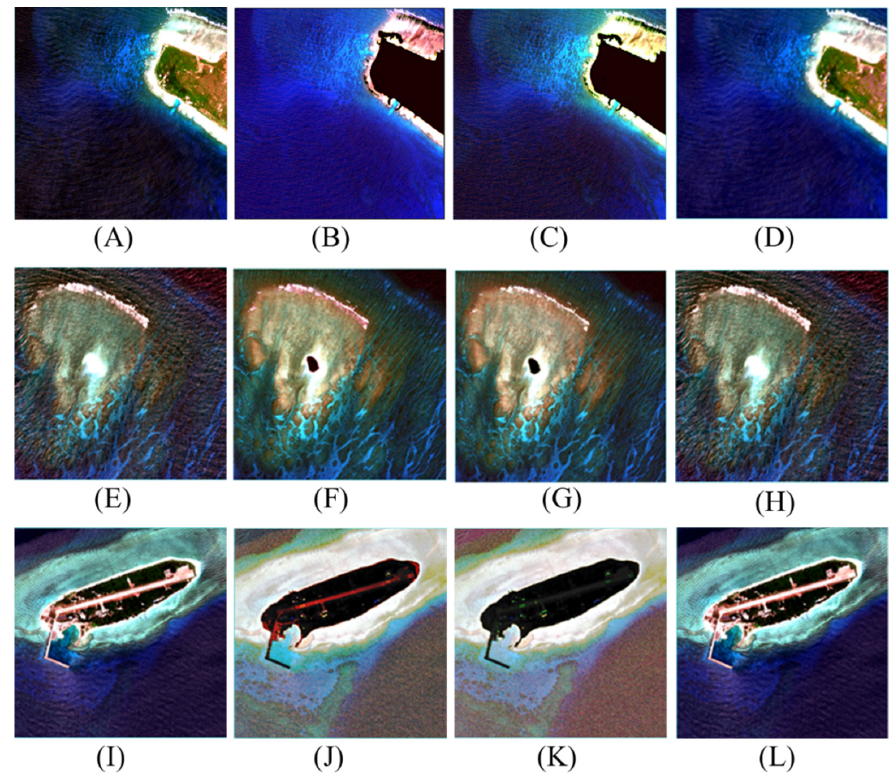
Figure 3. Satellite images before and after sun glint correction. ( A – D ) are the original image of Dong ‐ dao Island, the Hedley method, the Goodman method, and the ND ‐ SGC method, respectively. ( E – H ) are the original image of Tiexian Jiao, the Hedley method, the Goodman method, and the ND ‐ SGC method, respectively. ( I – L ) are the original image of Taiping Island, the Hedley method, the Goodman method, and the ND ‐ SGC method, respectively.